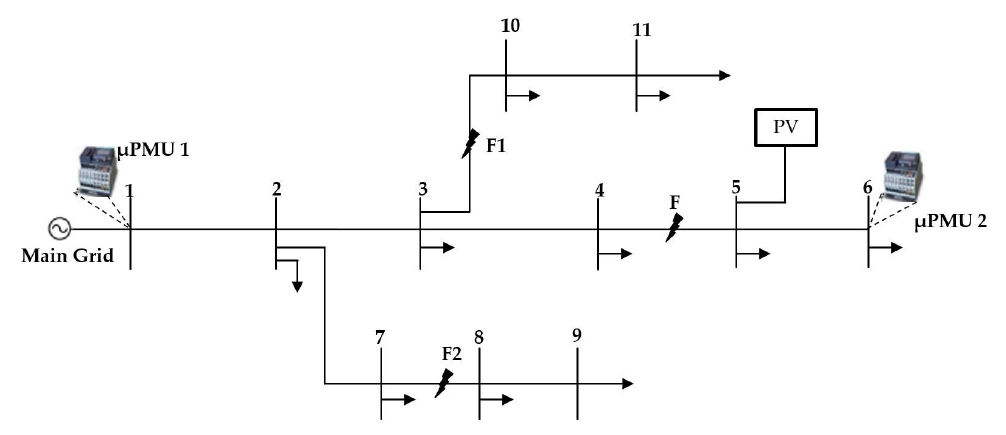
Figure 4. Examples of the fault location finding method in 11-bus distribution